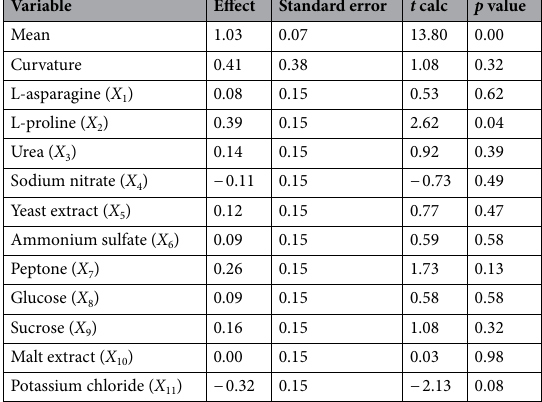
Table 2. Effect of variables on L-asparaginase production by Penicillium cerradense evaluated by Plackett– Burman experimental design.